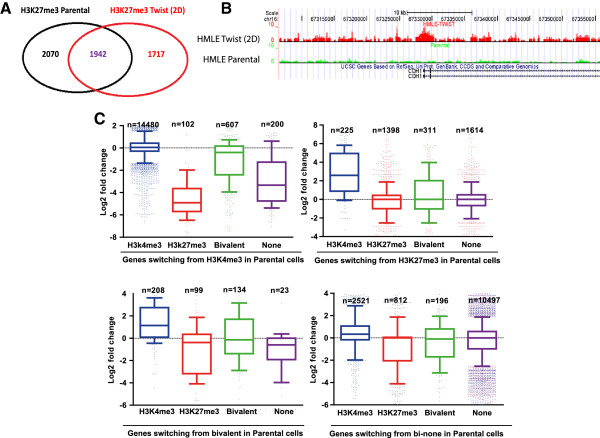
H3K27me3 switches orchestrate a mesenchymal cell-type specific gene expression signature. (A) Venn diagram of genes marked by H3K27me3 in human mammary epithelial cells (HMLE) vector cells and HMLE Twist cells. (B) Landscape of H3K27me3 mark in CDH1 gene (gain of H3K27me3 mark in HMLE Twist cells). (C) Box-plot of gene expression (the bars represent 10% and 90% extremes) for genes switching in HMLE vector cells from H3K4me3, H3K27me3, bivalent or neither marks to other histone mark combinations in HMLE Twist cells.